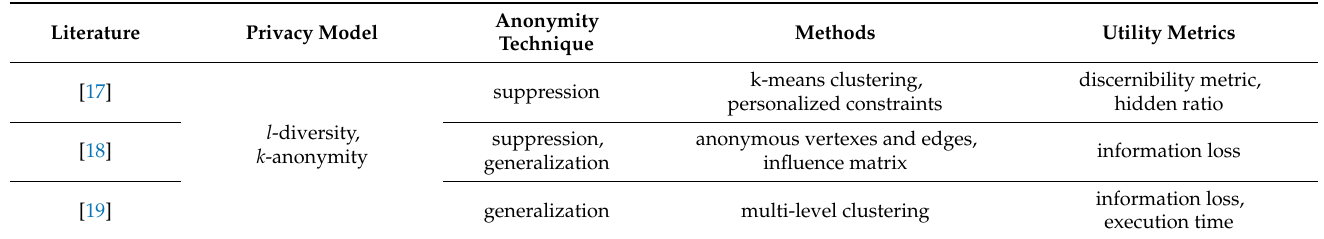
Table 4. Summary of anonymization